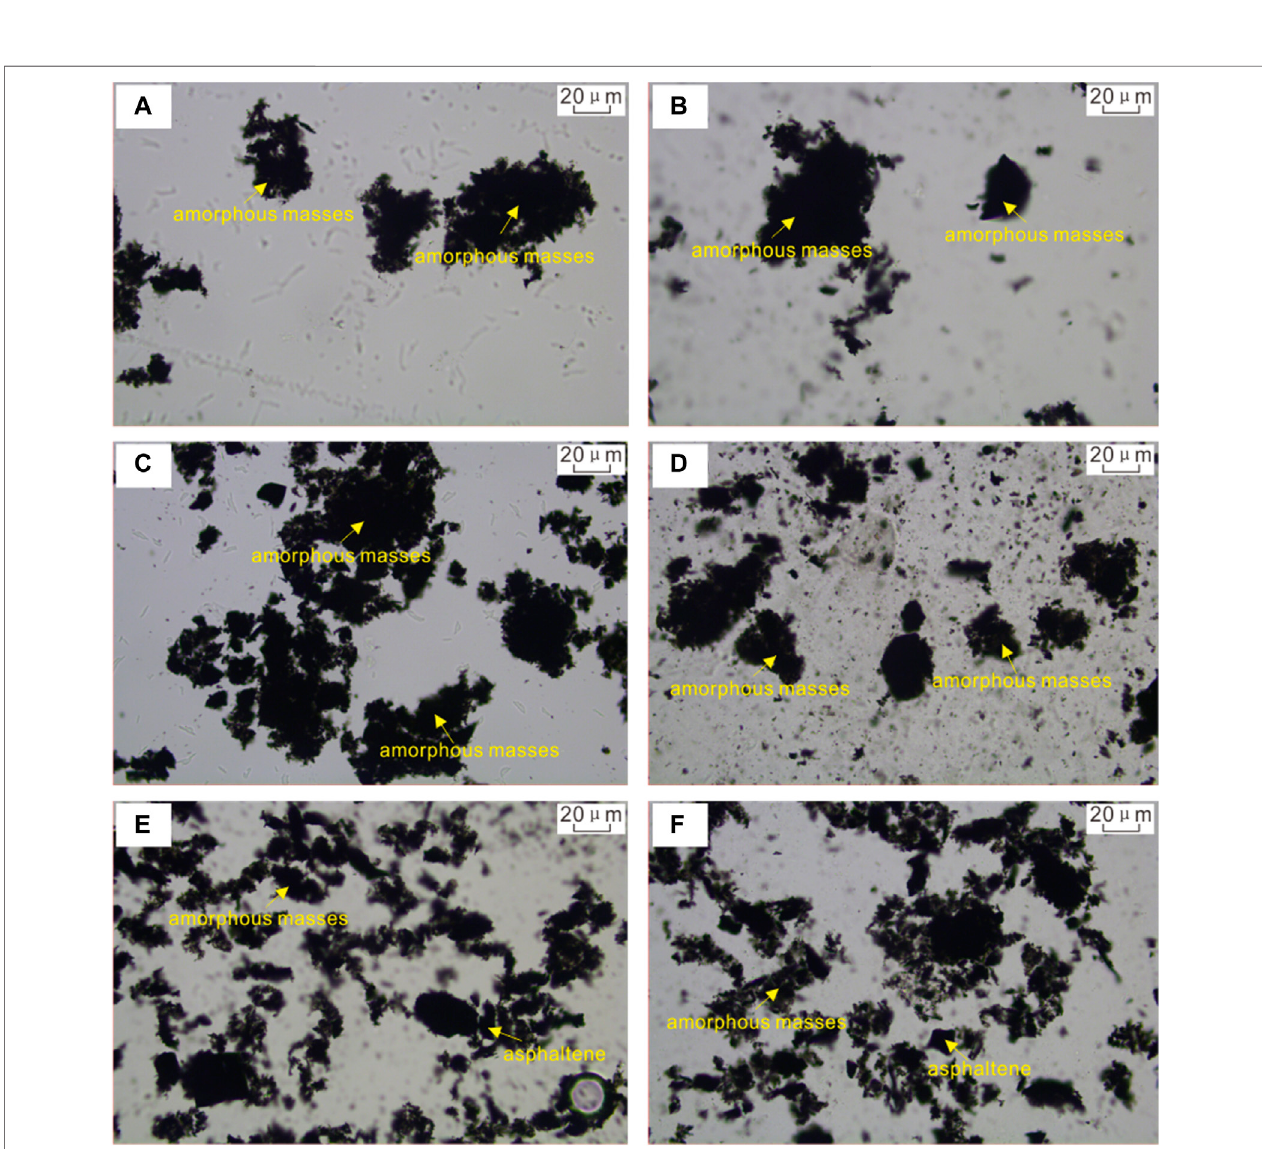
FIGURE2| Kerogen maceralfor theUpperPermianLinghao Formation shale/mudstone fromthestudied wellinNanpanjiangBasin. (A) Amorphous masses,Ling 1memberorganic-richshale,3,767.54 m. (B) Amorphousmasses,Ling1memberorganic-richshale,3,772.24 m. (C) Amorphousmasses,Ling2membermudstone, 3,557.75 m. (D) Amorphous masses, Ling 2 member mudstone, 3561 m. (E) Amorphous masses and asphaltene, Ling 3 member organic-rich shale, 3,408.92 m. (F) Amorphous masses and asphaltene, Ling 3 member organic-rich shale, 3,412.12 m.